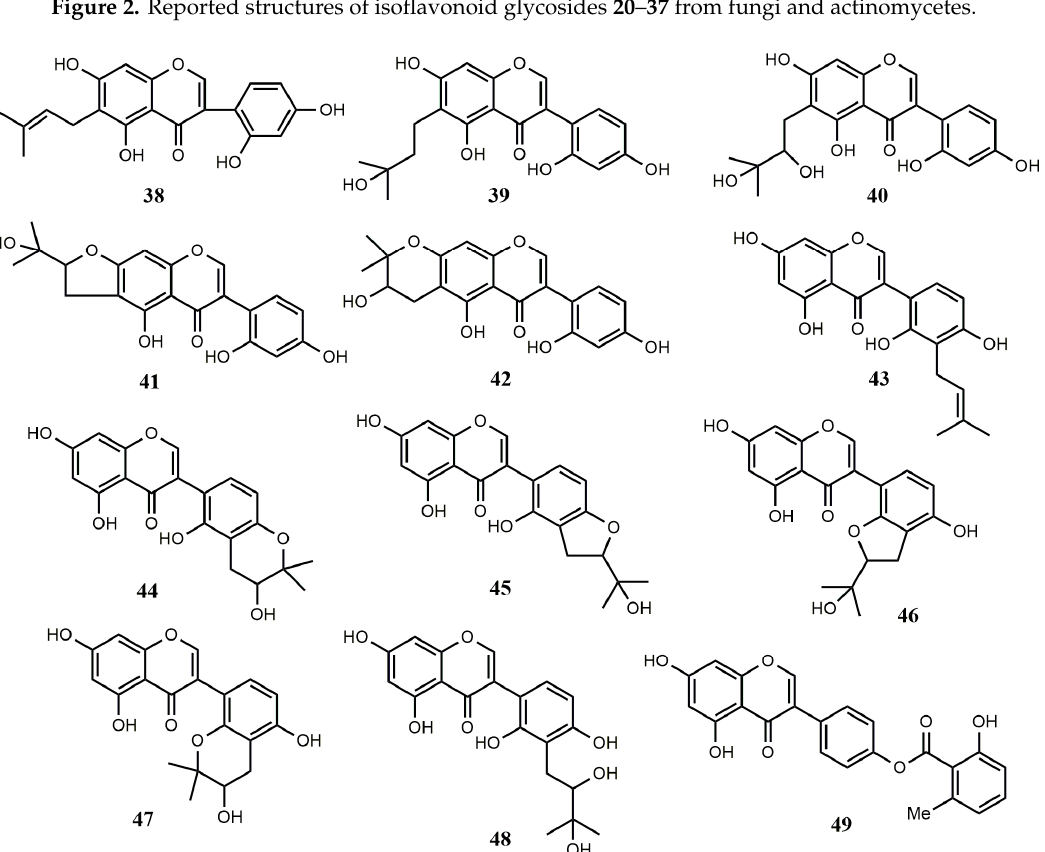
Figure 2. Reported structures of isoflavonoid glycosides 20 – 37 from fungi and actinomycetes.